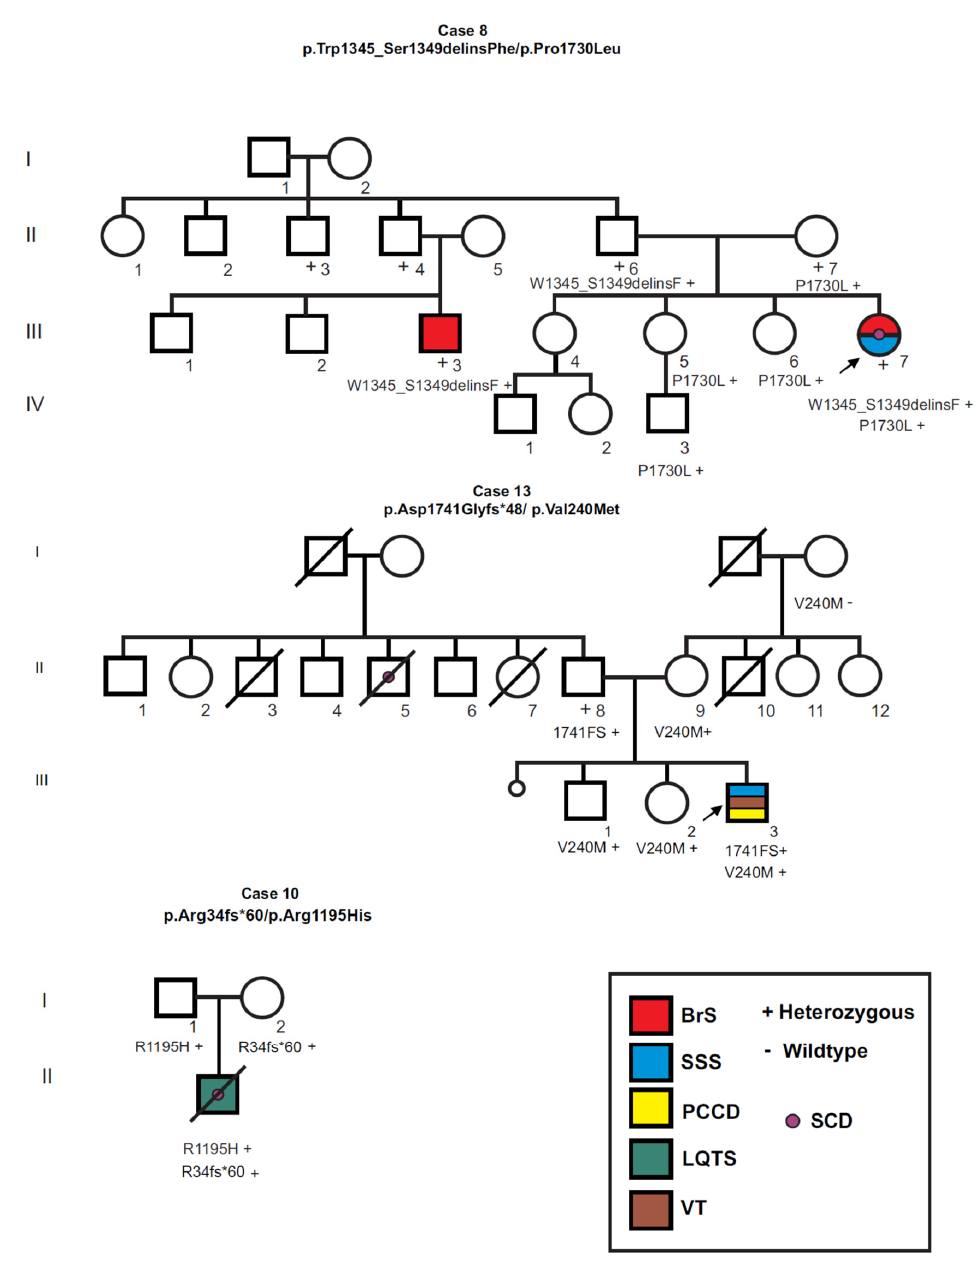
Figure 4. Pedigree of 3 overlap syndrome cases who were compound heterozygous for SCN5A mutations. Circles indicate females, squares, males; symbols with diagonal lines represent deceased individuals. Open symbols represent asymptomatic individuals, filled symbols were affected by arrhythmogenic syndromes according to the color code. SSS: sick sinus syndrome; PCCD: progressive cardiac conduction disease; VT: ventricular tachycardia; BrS: Brugada syndrome; LQTS: long QT syndrome; SCD: sudden cardiac